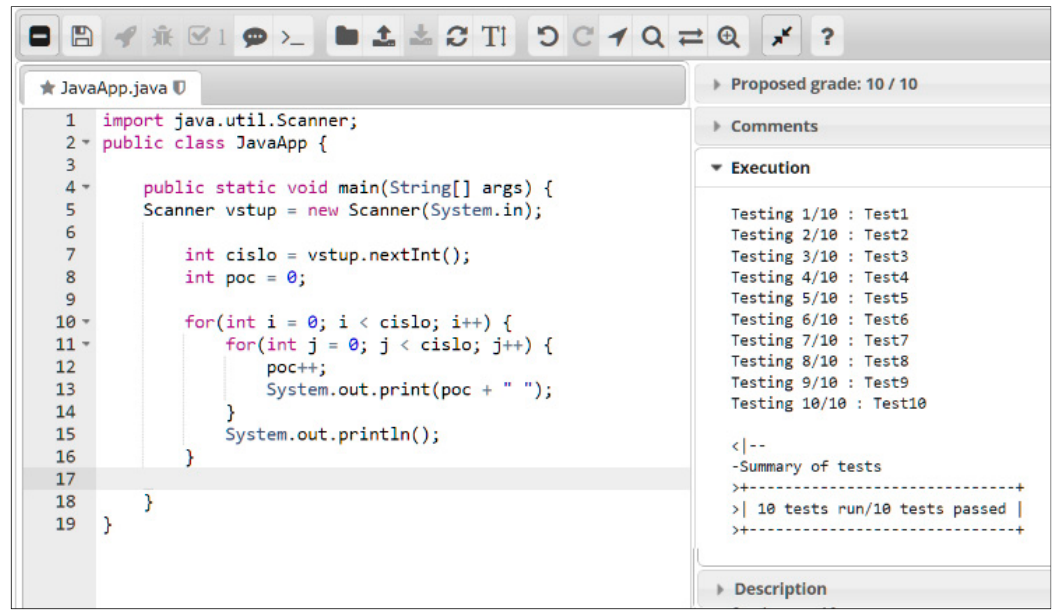
Figure 5. Virtual programming lab for Moodle [21].